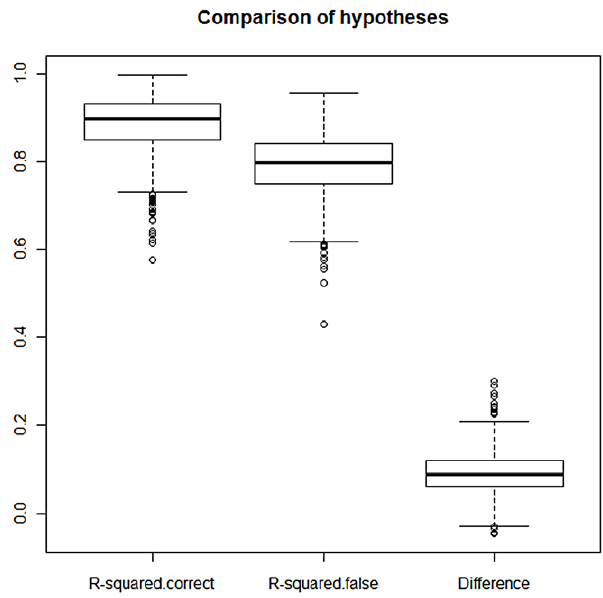
Figure 2. The correct model can be identified as higher values of R 2 were obtained, as shown in the box plot on the left hand side. A pairwise comparison of the 1000 simulations performed is shown in the far right box plot.